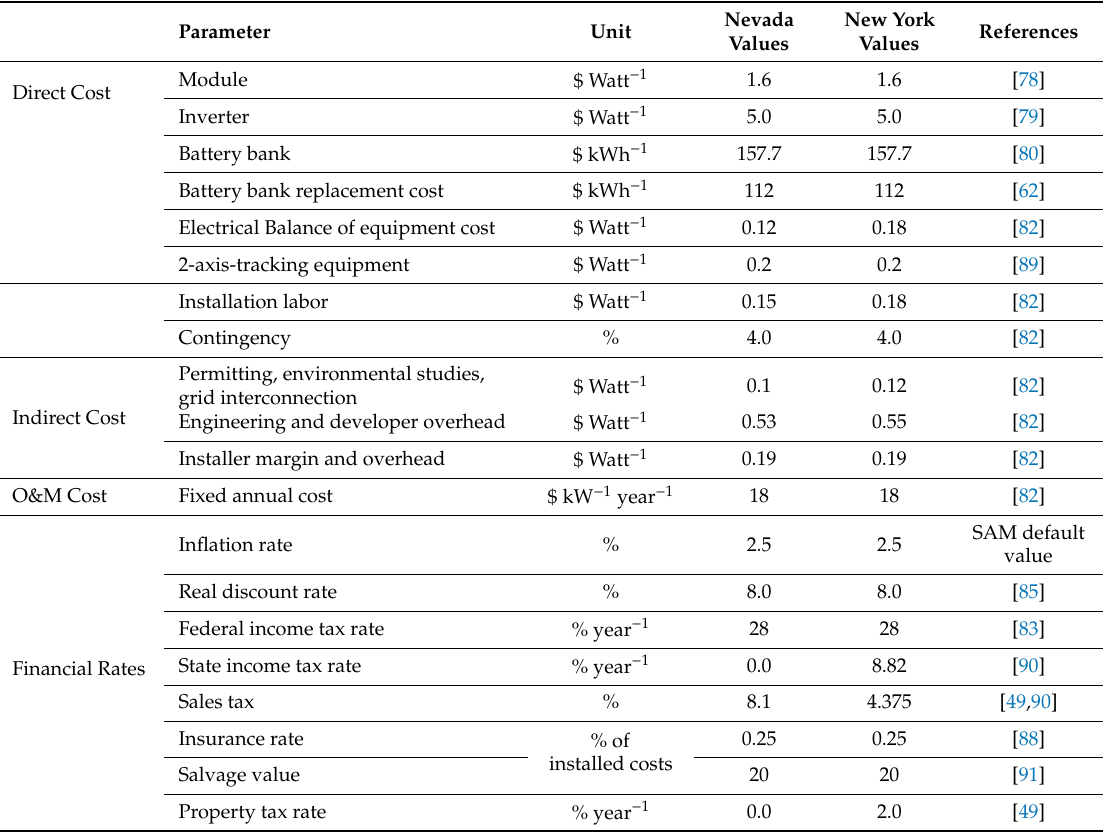
Table 4. Financial parameters used for economical assessment using system advisor